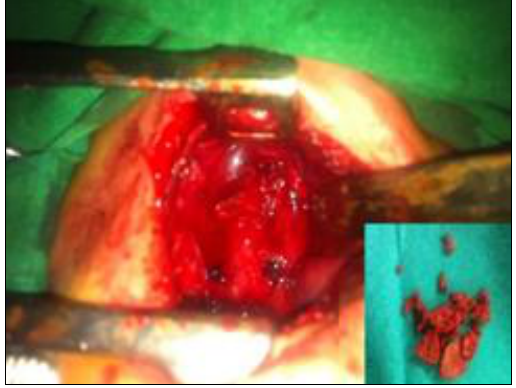
Figure 1: Intra-operative photograph revealing intact esophagus; inset shows extracted beetle nut